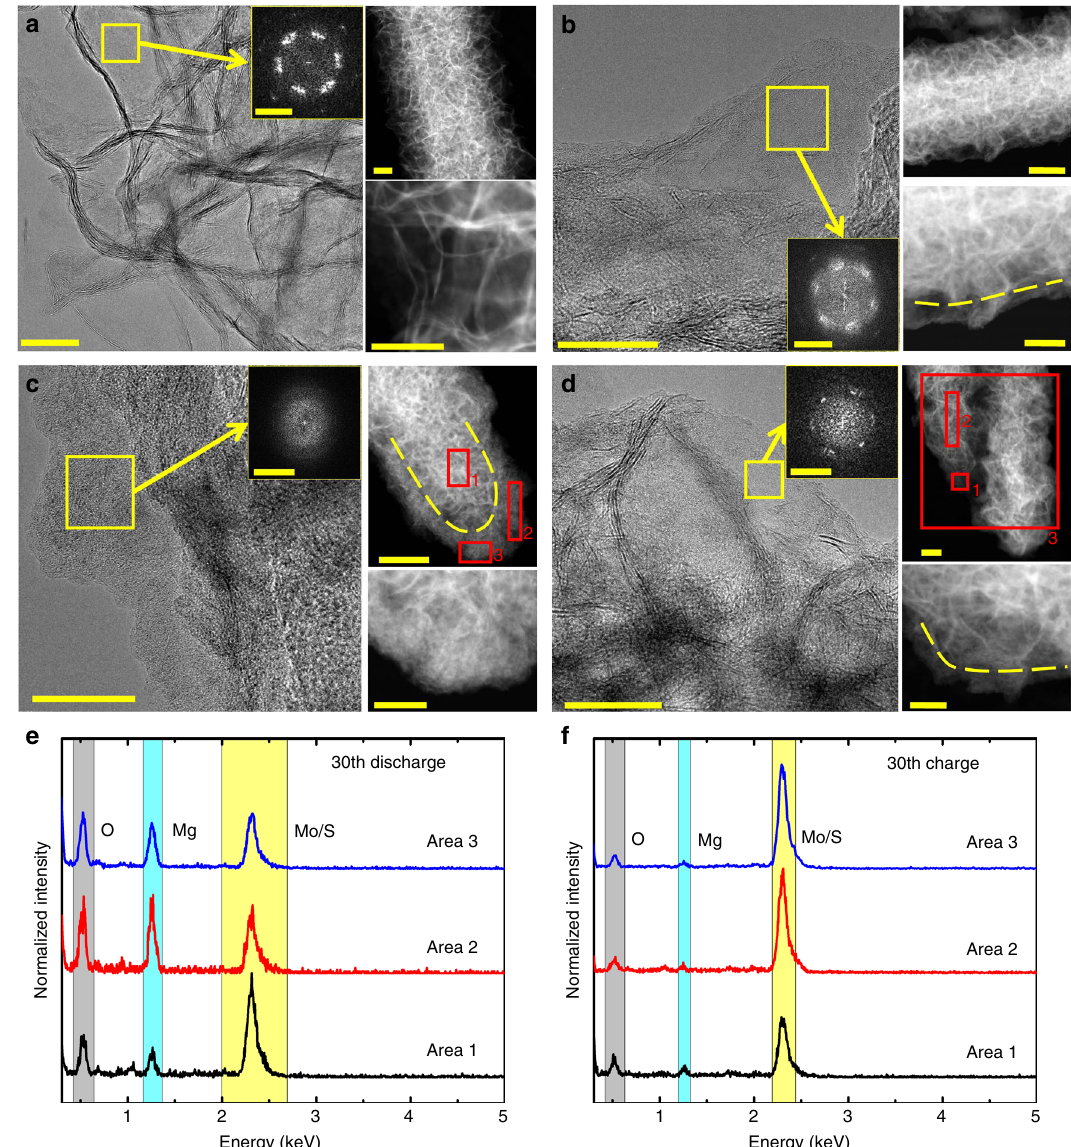
Fig. 4 Ex situ HRTEM measurement of MoS 2 @C-PNR electrodes. HRTEM image (left) with the FFT insert of the surface area and STEM-HAADF images (upper/lower) of MoS 2 @C-PNR electrodes at a the pristine state, b 10th discharged state, c 30th discharged state, and d 30th charged state. The yellow dashed lines indicate the border between the activated and inactive area. The scale bar of HRTEM images corresponds to 20 nm, the FFT insets to 5 1/nm, upper STEM-HAADF images to 100 nm, and lower STEM-HAADF images to 50 nm. The corresponding EDX spectra of the indicated areas in the STEM- HAADF images of the 30th discharged and 30th charged state are shown in ( e ) and ( f